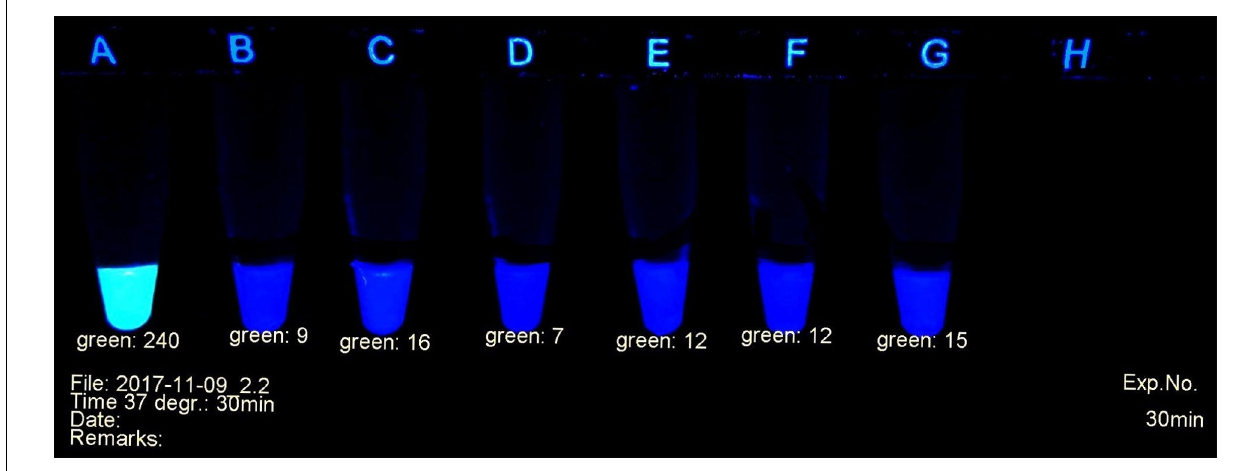
FIGURE 1 | Example of carbapenemase assessment under UV light. (A) E. coli ATCC 25922; (B) and (C) P. mirabilis OXA-48 Nos. 29bl and 29ca; (D) E. coli NDM No. 21bl; (E) K. pneumoniae KPC; No. 11bl; (F) A. baumanii OXA-40 No. 25bl; (G) E. ludwigii hyper-producing AmpC No. 83bl.